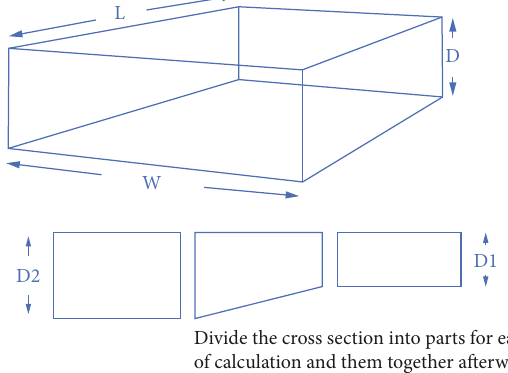
Figure 13: The size of swimming pool treatment boat diagram.